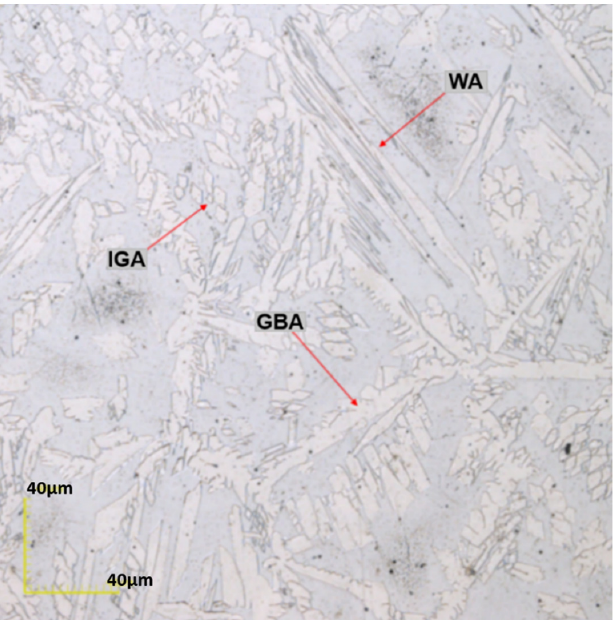
Figure 4. Representative microstructure found in the FZ. Electrolytic etching with 10% oxalic acid. Confocal microscopy (model Olympus OLS400, Shinjuku, Tóquio, Japão), 1075× magnification.